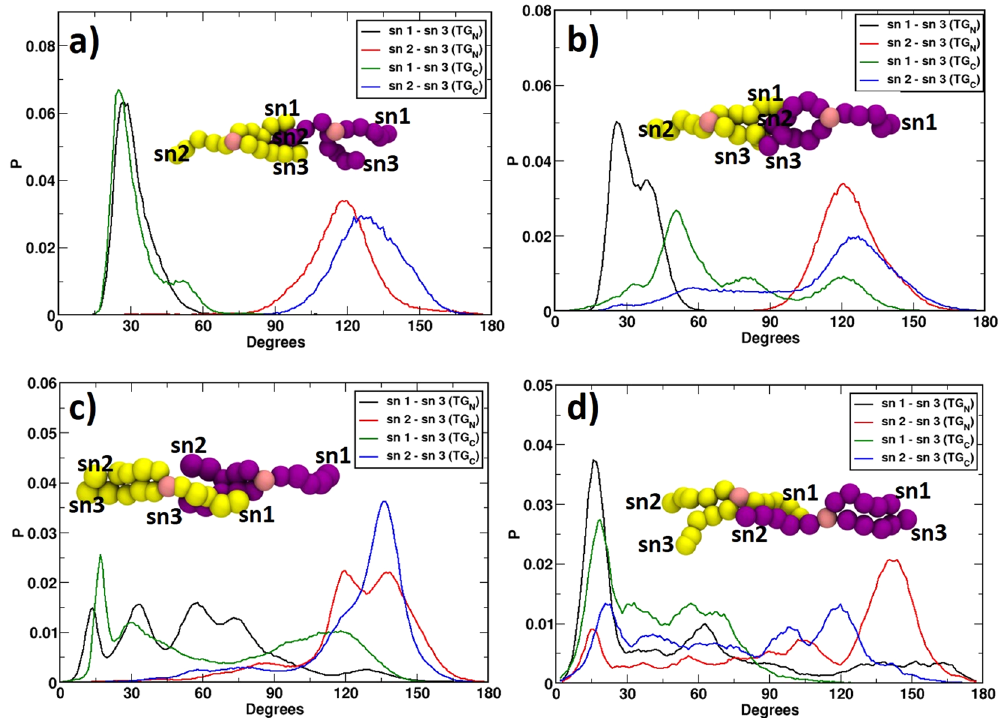
Figure 4. Distribution of angles between the three oleate chains, sn1, sn2, sn3 of both TGs from CG simulation data. Results are shown for bound TGs in CETP with ( a ) “parallel N-N” orientation, ( b ) “antiparallel N-C” orientation, ( c ) “parallel C-C” orientation, and ( d ) “antiparallel C-N” orientation. The color codes of the graphs are included in insets. Initial TG conformations (TG N : yellow, TG C : purple) are shown for easy